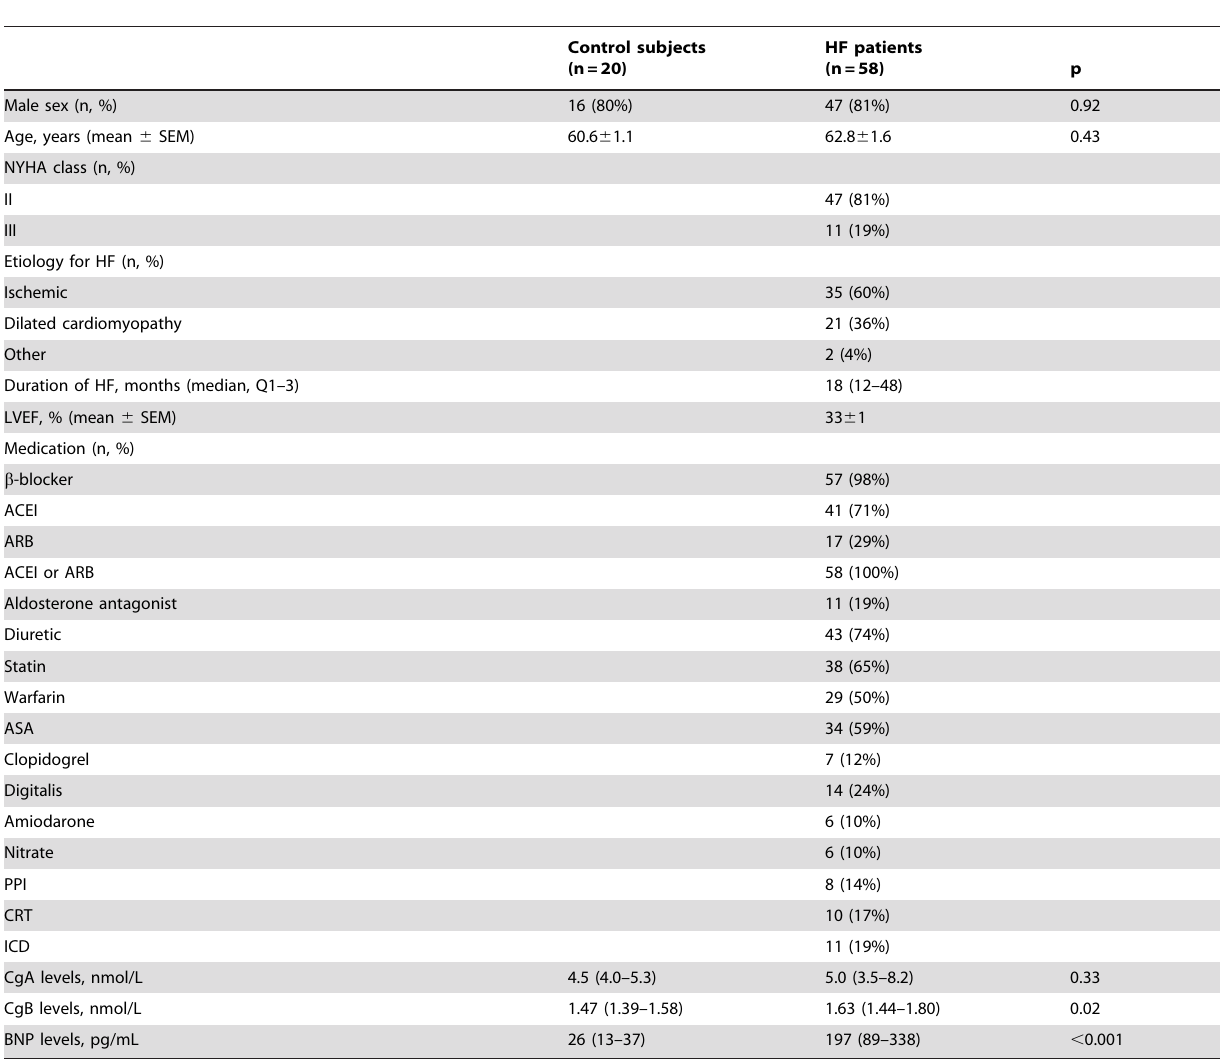
Table 2. Descriptive statistics of heart failure patients and control